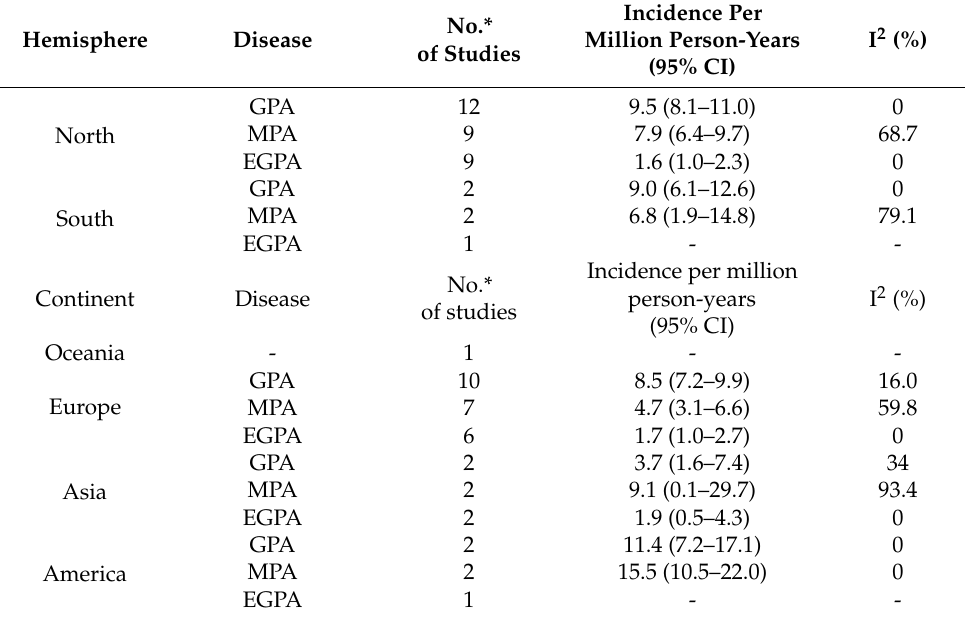
Table 3. Pooled incidence of ANCA-associated vasculitis by geographic region (number of studies included, 95% CI, and I 2